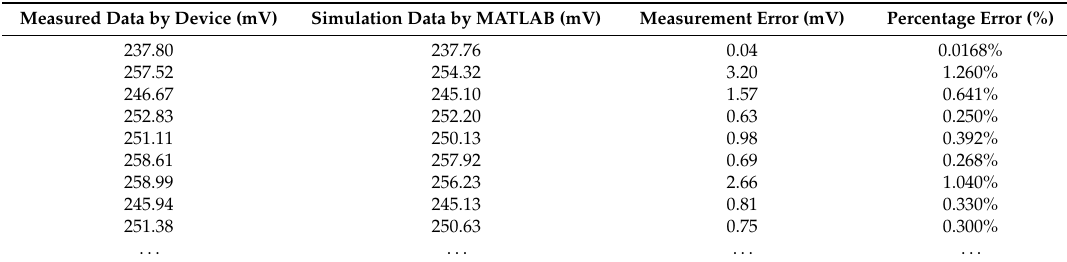
Figure 8. The simulation resistance network in MATLAB. Table 2. The part results of the measurement and simulation.